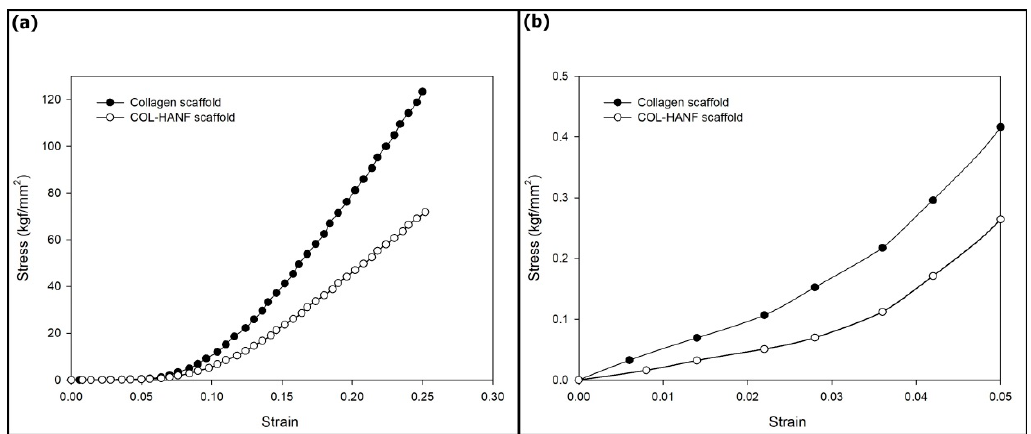
Figure 6. SEM images of the ( a ) COL scaffold and ( b ) COL-HANF scaffold.